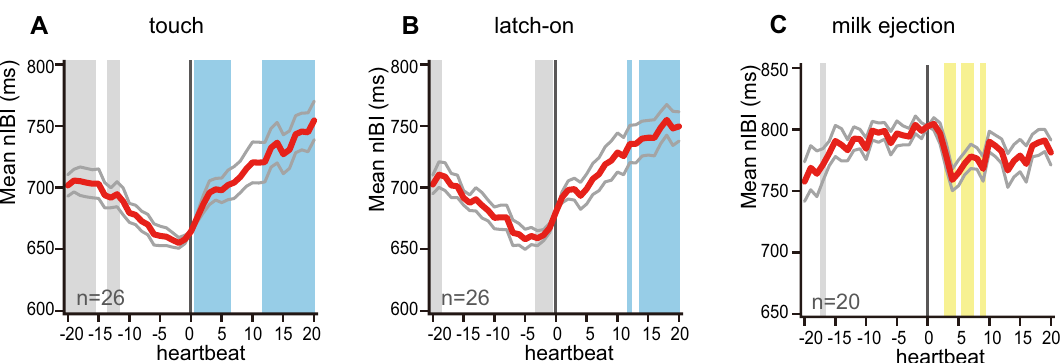
Fig. 3 Maternal IBI transition at the initiation of breastfeeding and at the perceiving of milk ejection. Data from which each event timing could be extracted among the 26 participants were analyzed, when the infant’s face touched the mother’s breast ( A ), when the infant latched on to the nipple ( B ), and when the mother reported perceiving a milk ejection ( C ). Peri-event nIBIs are shown in mean (red lines) shaded colors indicate significant differences ( p < 0.05) compared to the nIBI at heartbeat increased after the microevent; grey, higher or lower values before the microevent) by Steel’s